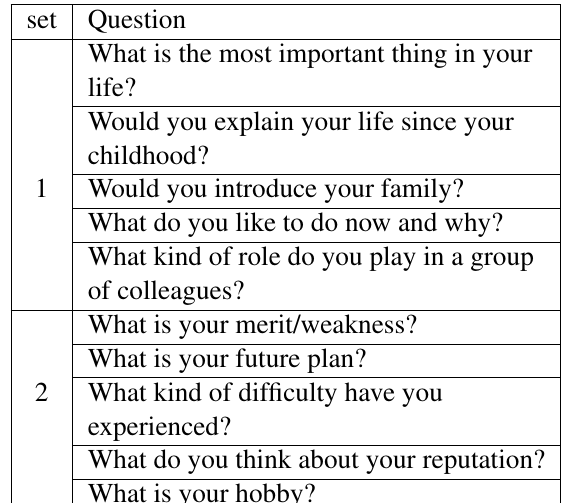
Table 1. List of questions.(Source: findings from the prelimi- nary study)